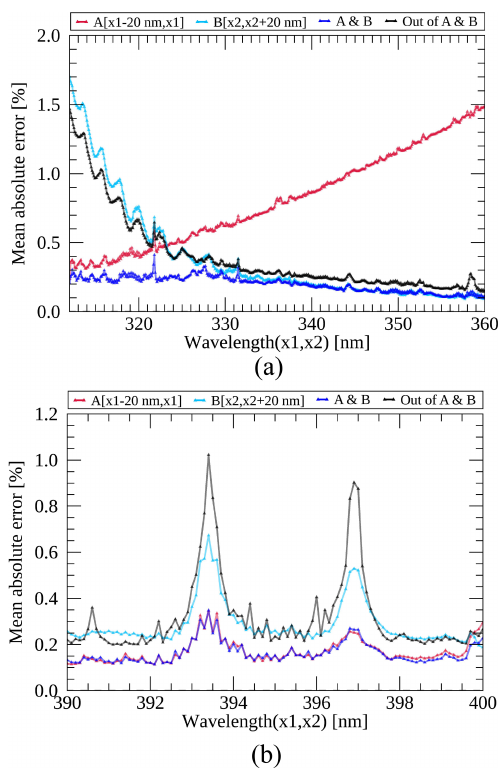
Figure 14. Mean absolute errors between the reproduced and mea- sured radiances at (a) ozone absorption and (b) Fraunhofer lines with different input cases. The x 1 and x 2 in the legend indicate the wavelengths at the boundary of output spectral bands, respectively. The absolute error is calculated between the ML and GEMS radi- ances and divided by the latter in percent.